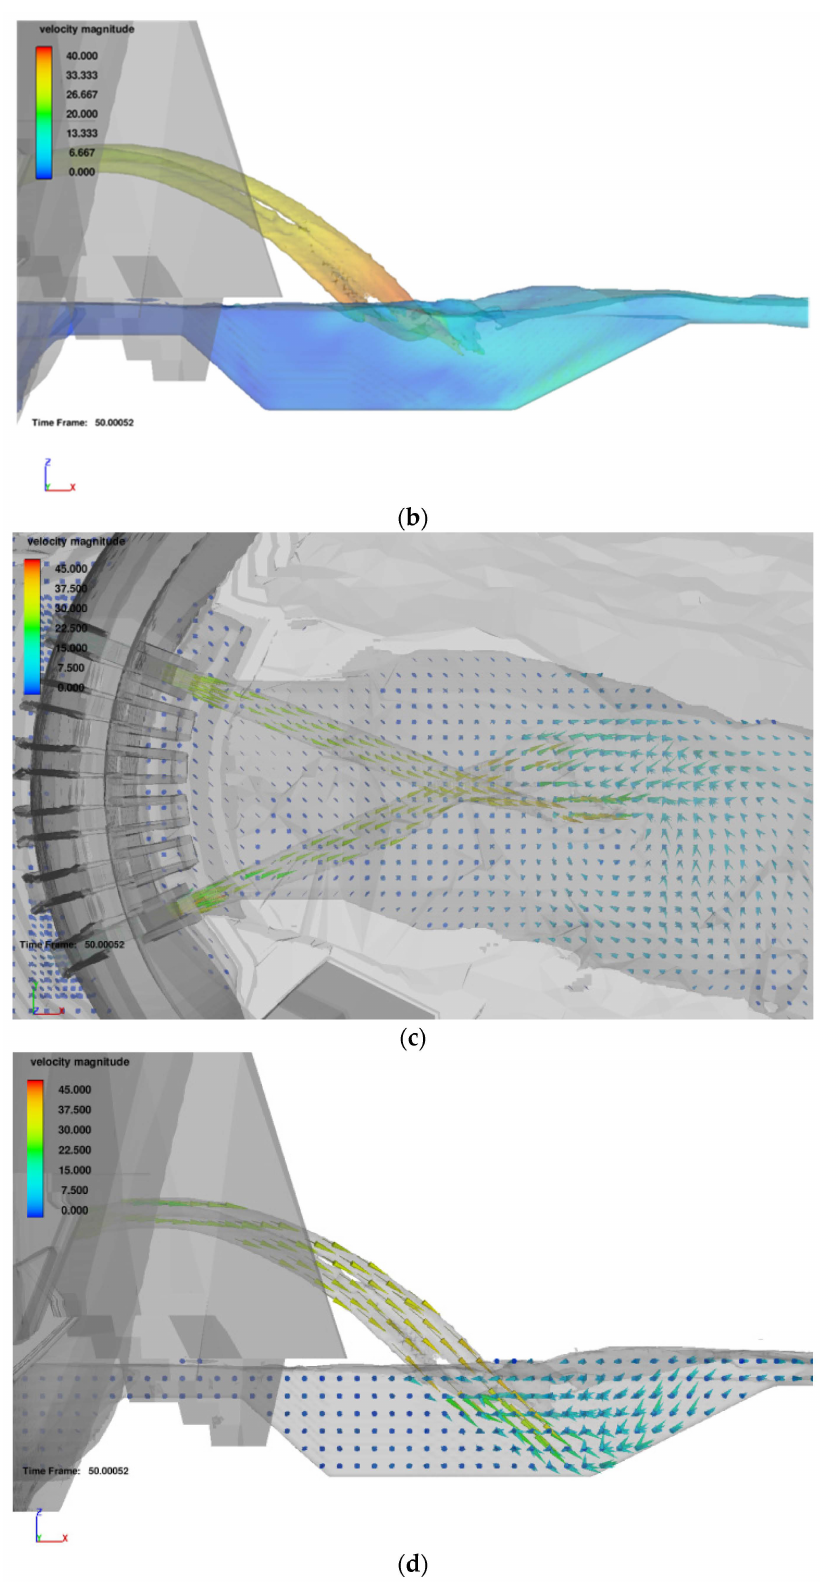
Figure 15. Flow velocity in the air and in the pre-excavated stilling basin (Prototype scale. Units in m/s): ( a ) Spatial view of the half-height outlet; ( b ) Lateral view of the half-height outlet; ( c ) Top view of the velocity vectors with the half-height outlet; ( d ) Lateral view of the velocity vectors with the half-height